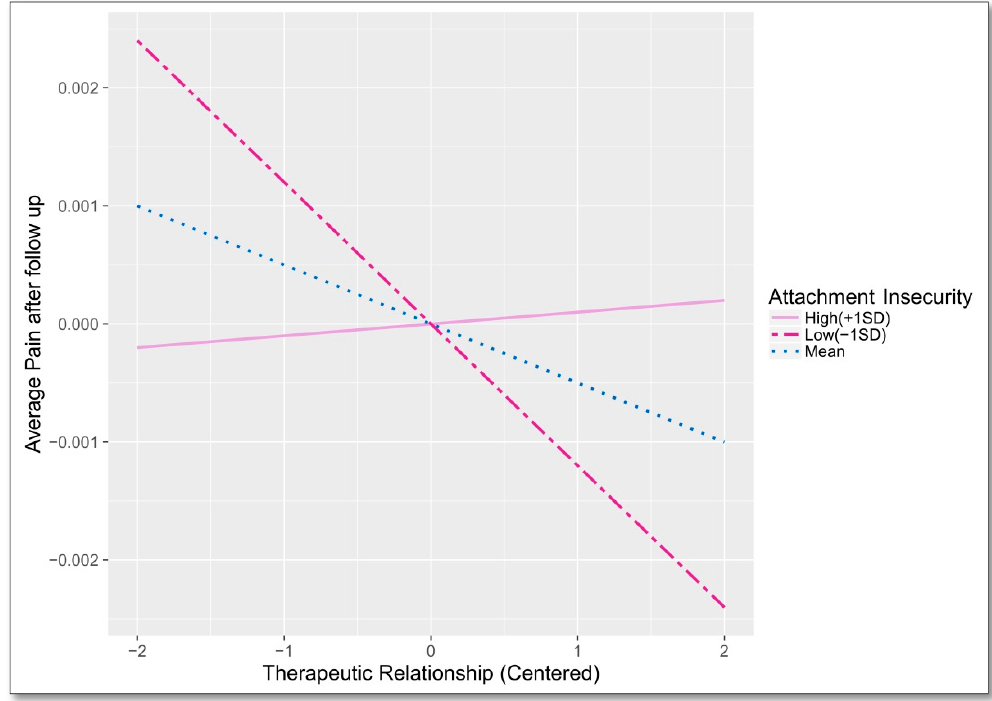
Figure 6. Moderated effect of attachment insecurity on the relationship between working alliance and average pain after follow